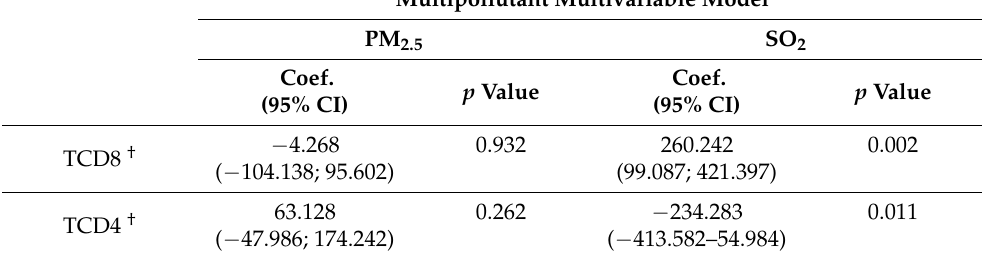
Table 6. Multipollutant multivariable regression models of pollutants and cord blood cells previously associated in PCA. PC2 from air pollutants and PC1 from cell types with ≥ 0.4 for the highest loadings and ≤− 0.4 for the lowest loadings. After Bonferroni correction, significance was considered when p <